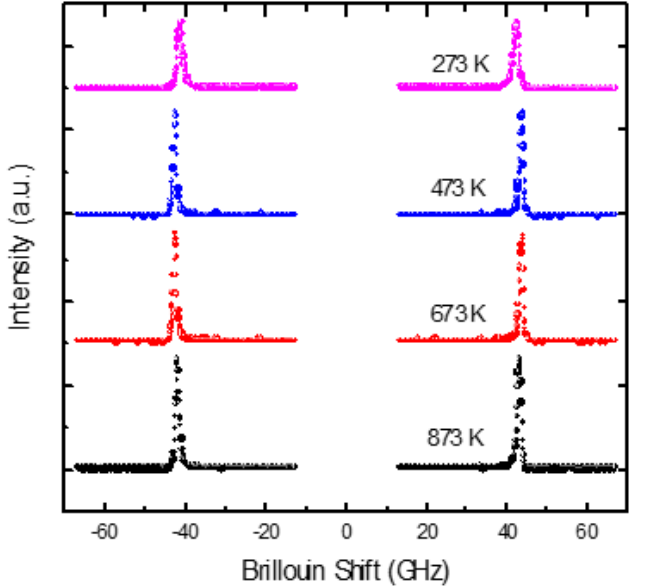
Figure 1. Brillouin spectra of PMT at different temperatures(Reprinted with kind permission from Ref. [41]. 2015, the European Physical Journal (EPJ)).